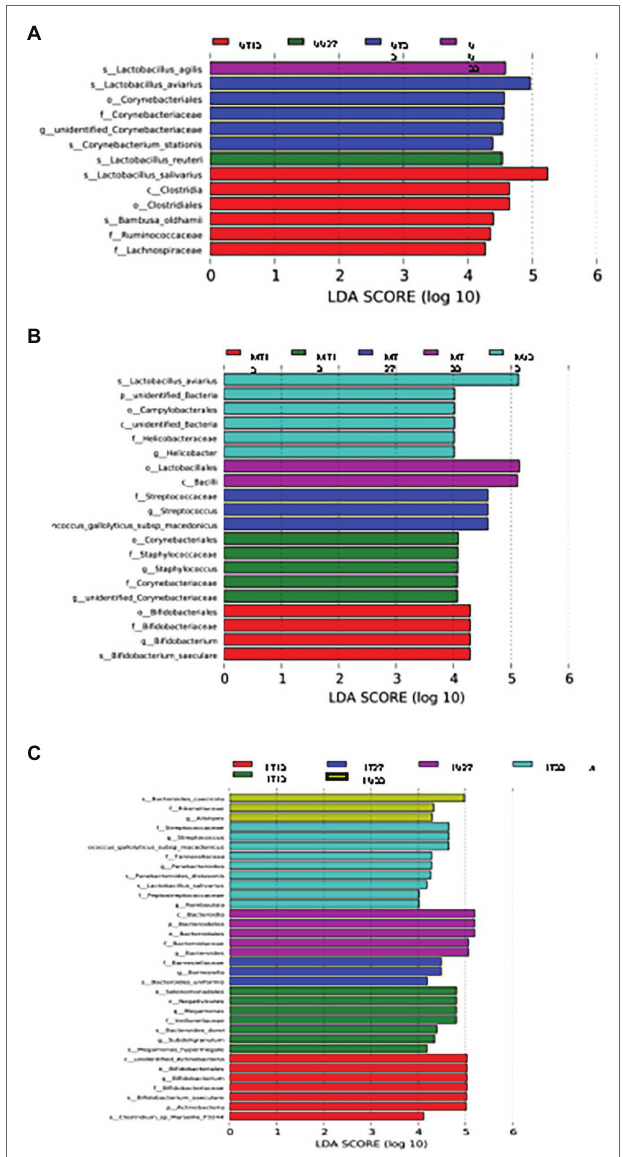
FIGURE 5 | LEfSe analysis of the upper (A) , middle (B) , and lower (C)